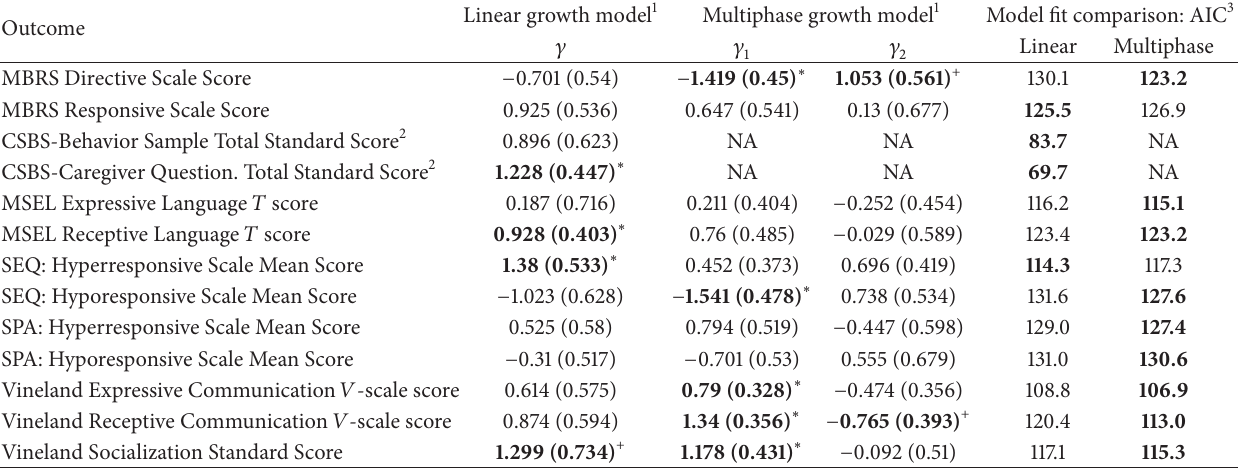
Table 4: Estimated difference in growth between treatment and control from two difference model specifications.